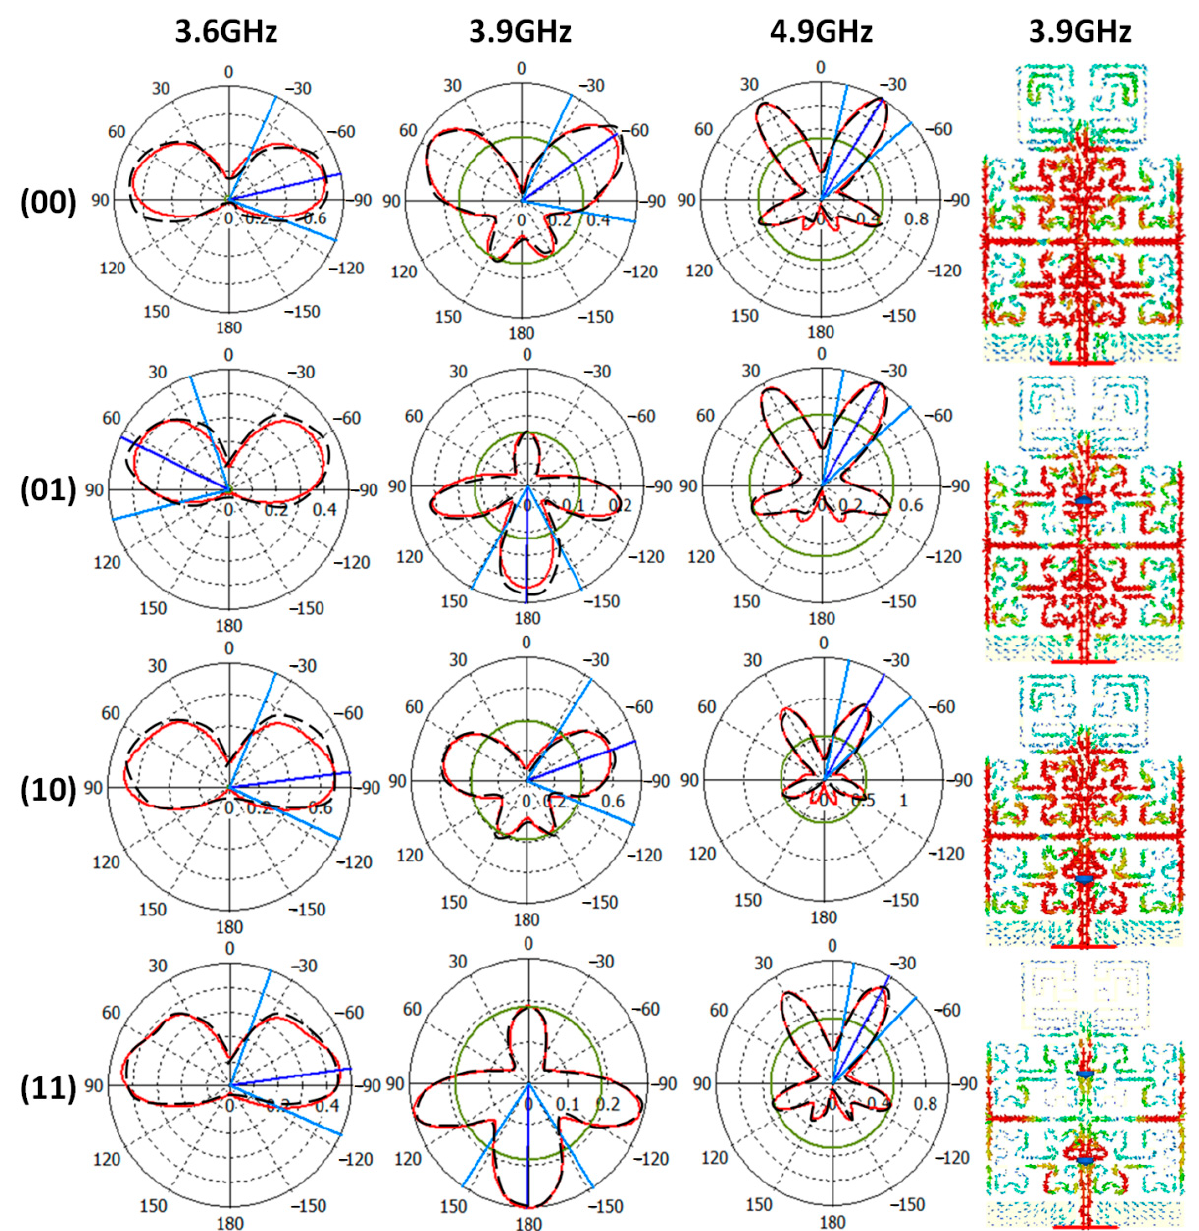
Figure 9. Measured radiation patterns at 3.6 GHz, 3.9 GHz, and 4.9 GHz and current distributions at 3.9 GHz only. Note: The black denoted line is for measurements and the red solid line for simulated results. In addition, the current distributions are from simulation only.